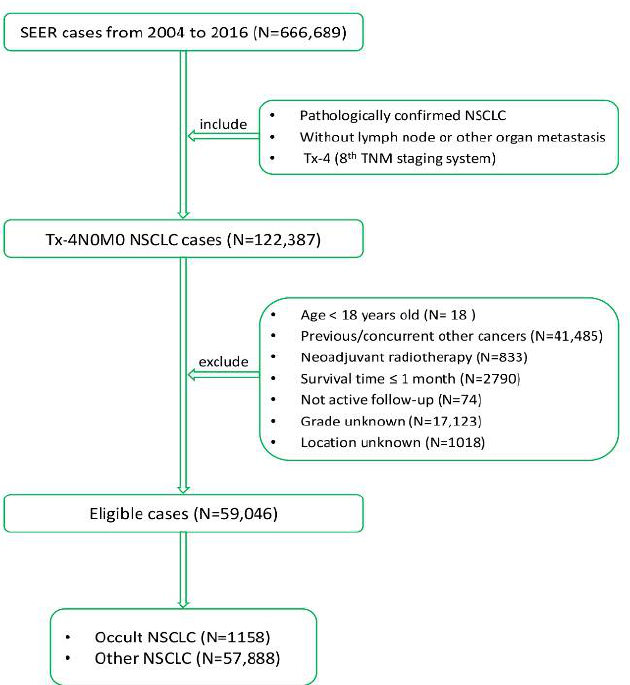
Figure 1. The study algorithm for patient enrollment in this study. SEER, Surveillance, Epidemiol- ogy, and End Results; NSCLC, non-small cell lung cancer; TNM,